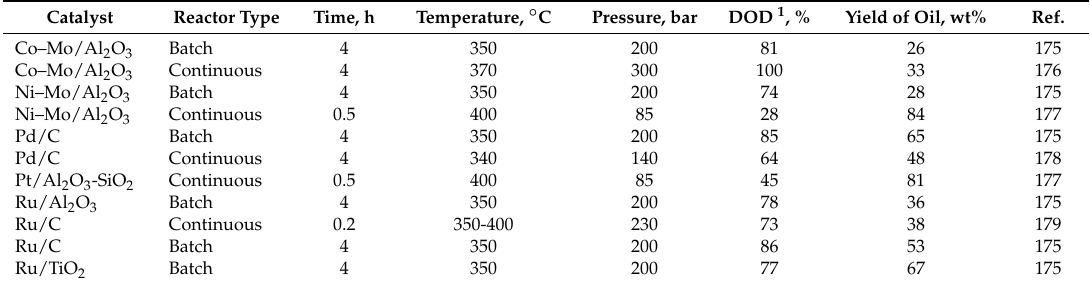
Table 7. Review of the catalysis research for the hydrotreating of bio-oil.